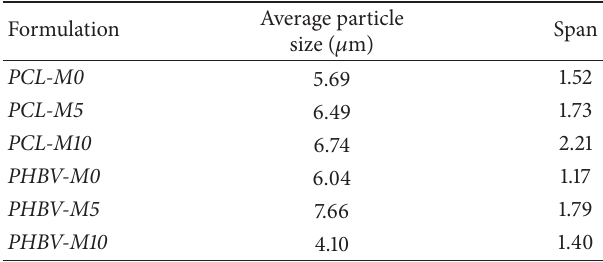
Table 4: Particle size and granulometric size distribution of PCL and PHBV